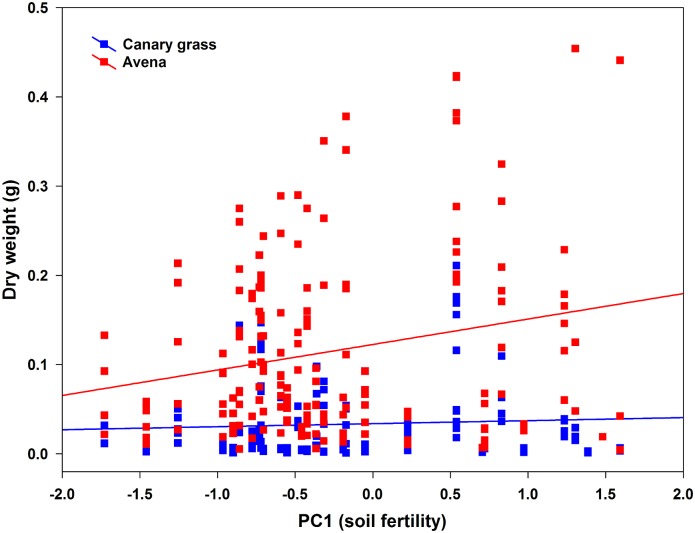
Positive linear relationships between seedling dry weight (g) and soil fertility (PC1) for the Canary grass (r = 0.054, P = 0.515, R2 = 0.003) and Avena (r = 0.214, P = 0.004, R2 = 0.046).Note that even though both species show a positive relationship, it only was significant for Avena.